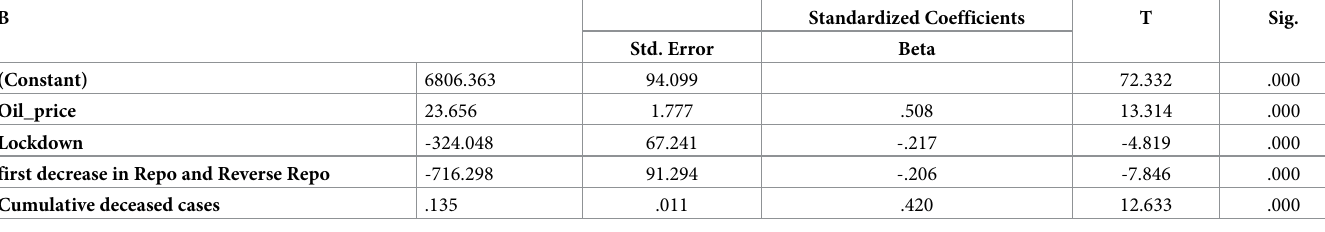
Table 12. Coefficients of the reduced linear regression model without